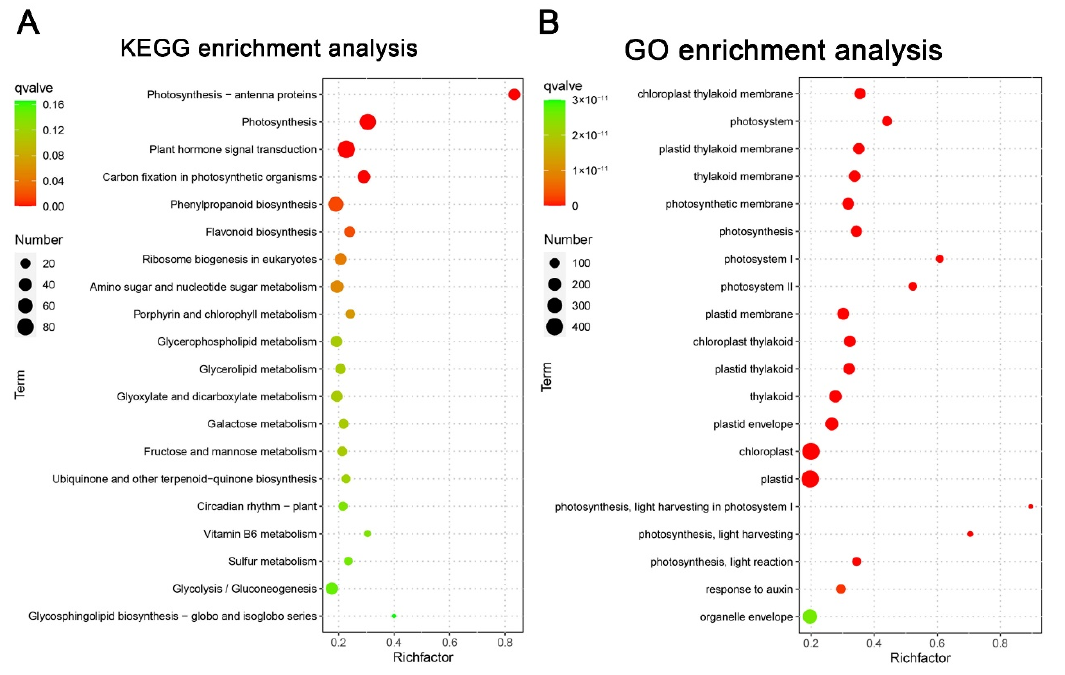
Figure 6. RNA-seq analysis of DEGs in CaFtsH1 -silenced plants compared with those in the negative controls. ( A ) KEGG pathway enrichment analysis of DEGs. ( B ) GO enrichment analysis of DEGs.